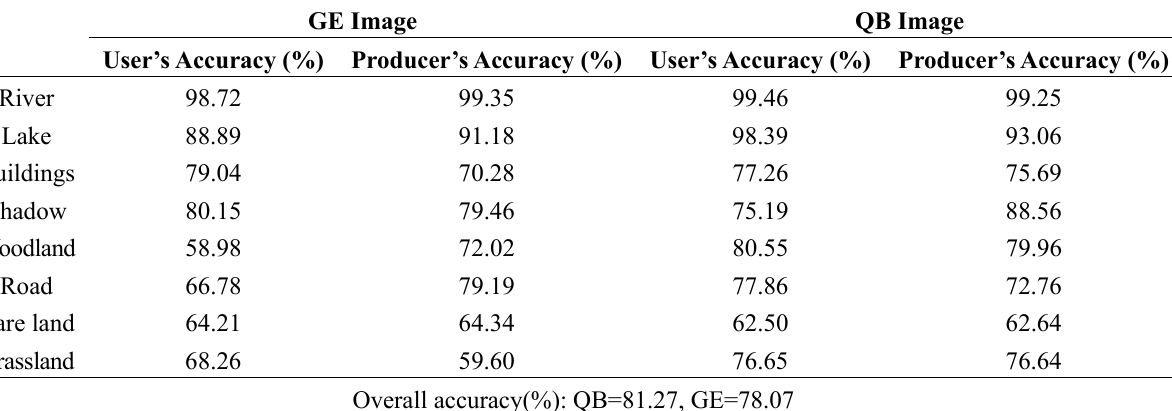
Table 4. Comparison of classification accuracy between GE and QB